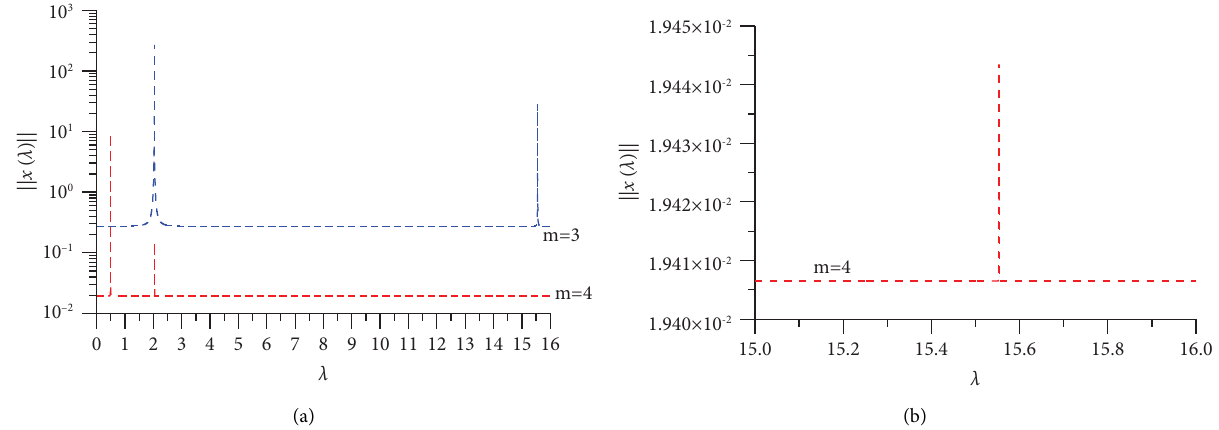
Figure 11: For Example 9, (a) in the interval [ 0 , 16 ] showing two picks of ‖ x ‖ with m � 3 and with m � 4, and (b) a pick of ‖ x ‖ with m � 4 is enlarged in the interval [ 15 , 16 ]